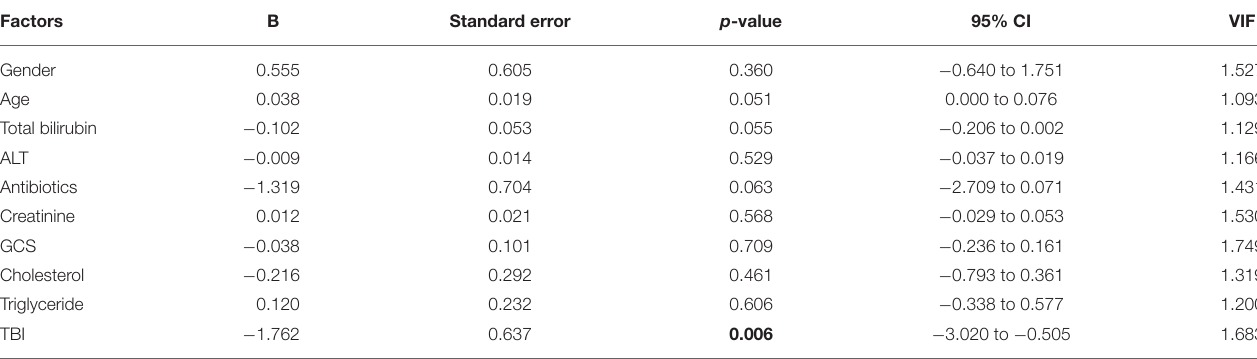
TABLE 3 | Linear regression analysis for serum bile acid level of whole cohort.